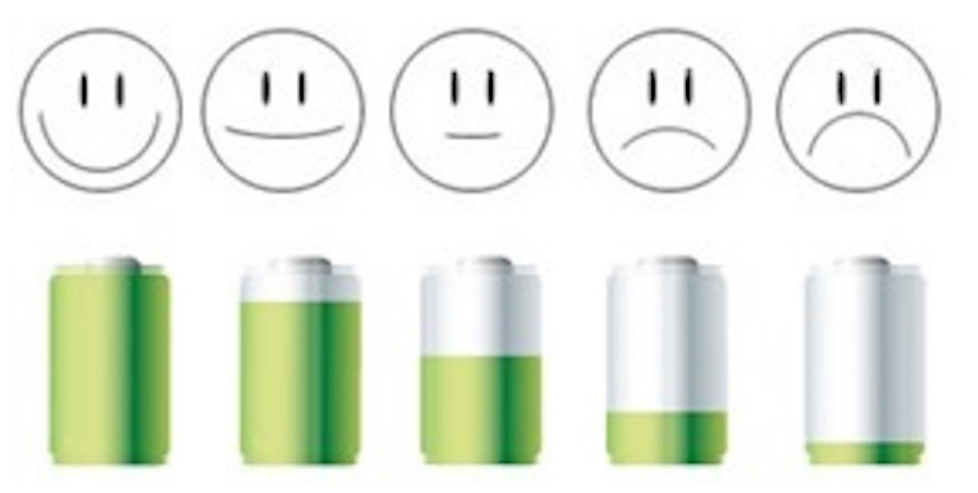
Figure 1. Visual analogue scales for mood and fatigue.